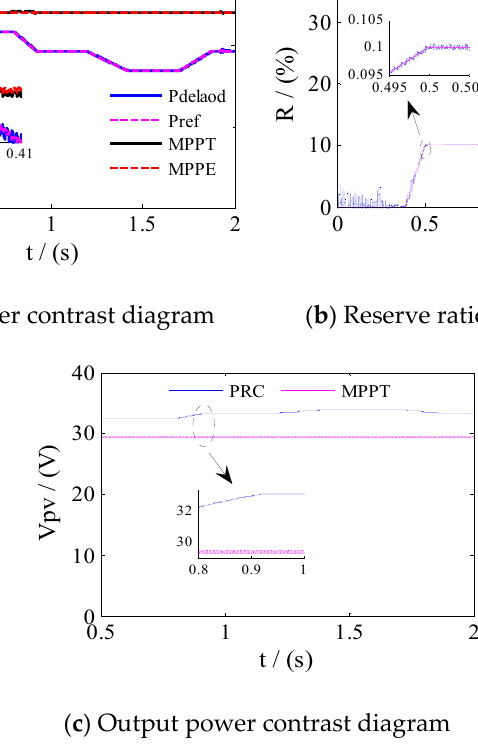
Figure 6. PV-PRC mode simulation waveform.